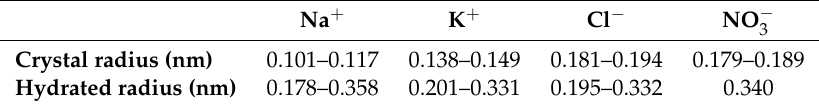
. Data obtained from 3